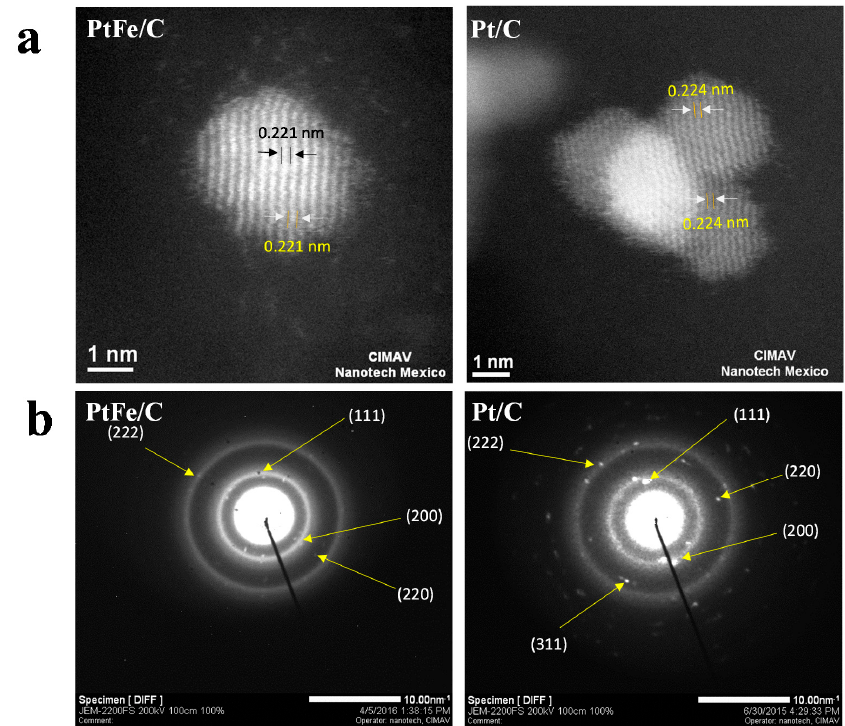
Figure 3. HR-TEM micrographs of Pt/C and PtFe/C nanocatalysts. ( a ) Z-contrast of a set of nanoparticles; ( b ) Selected area electron diffraction patterns.